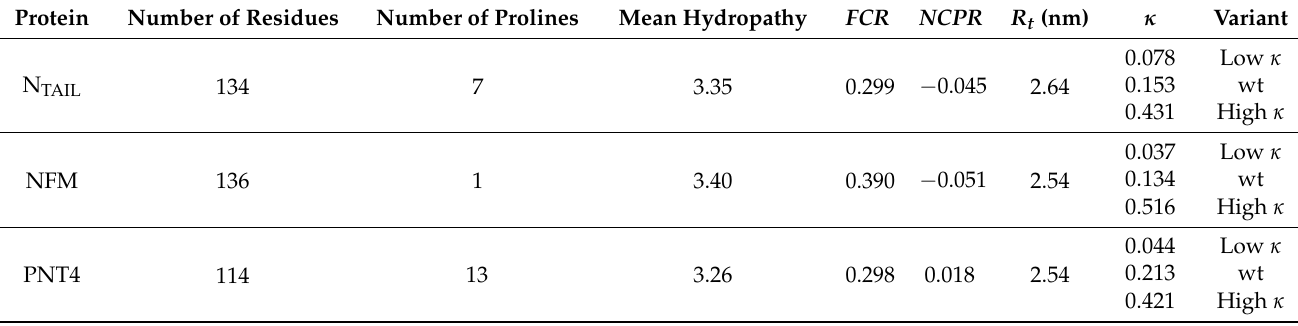
Table 1. Features of the three model proteins and their derived κ variants. Sequence features were computed using CIDER [28]; the theoretical radius R t was calculated according to Marsh and Forman-Kay